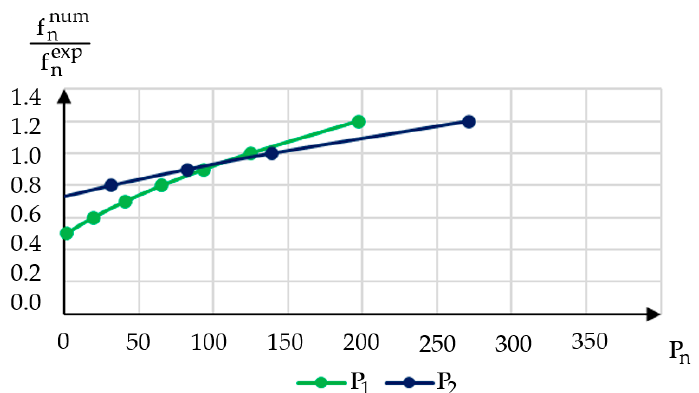
Figure 13. Change of force values depending on the ratio of numerical and experimental frequency values for two mode shapes (P 1 , P 2 ).